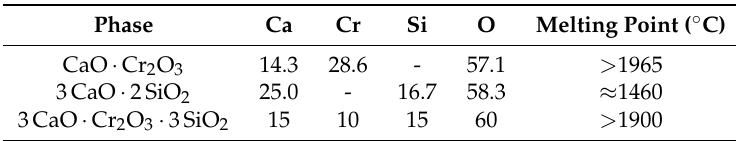
Table 6. Stoichiometric theoretical chemical compositions of elements in the given phases (at%) and their melting points ( ◦ C)